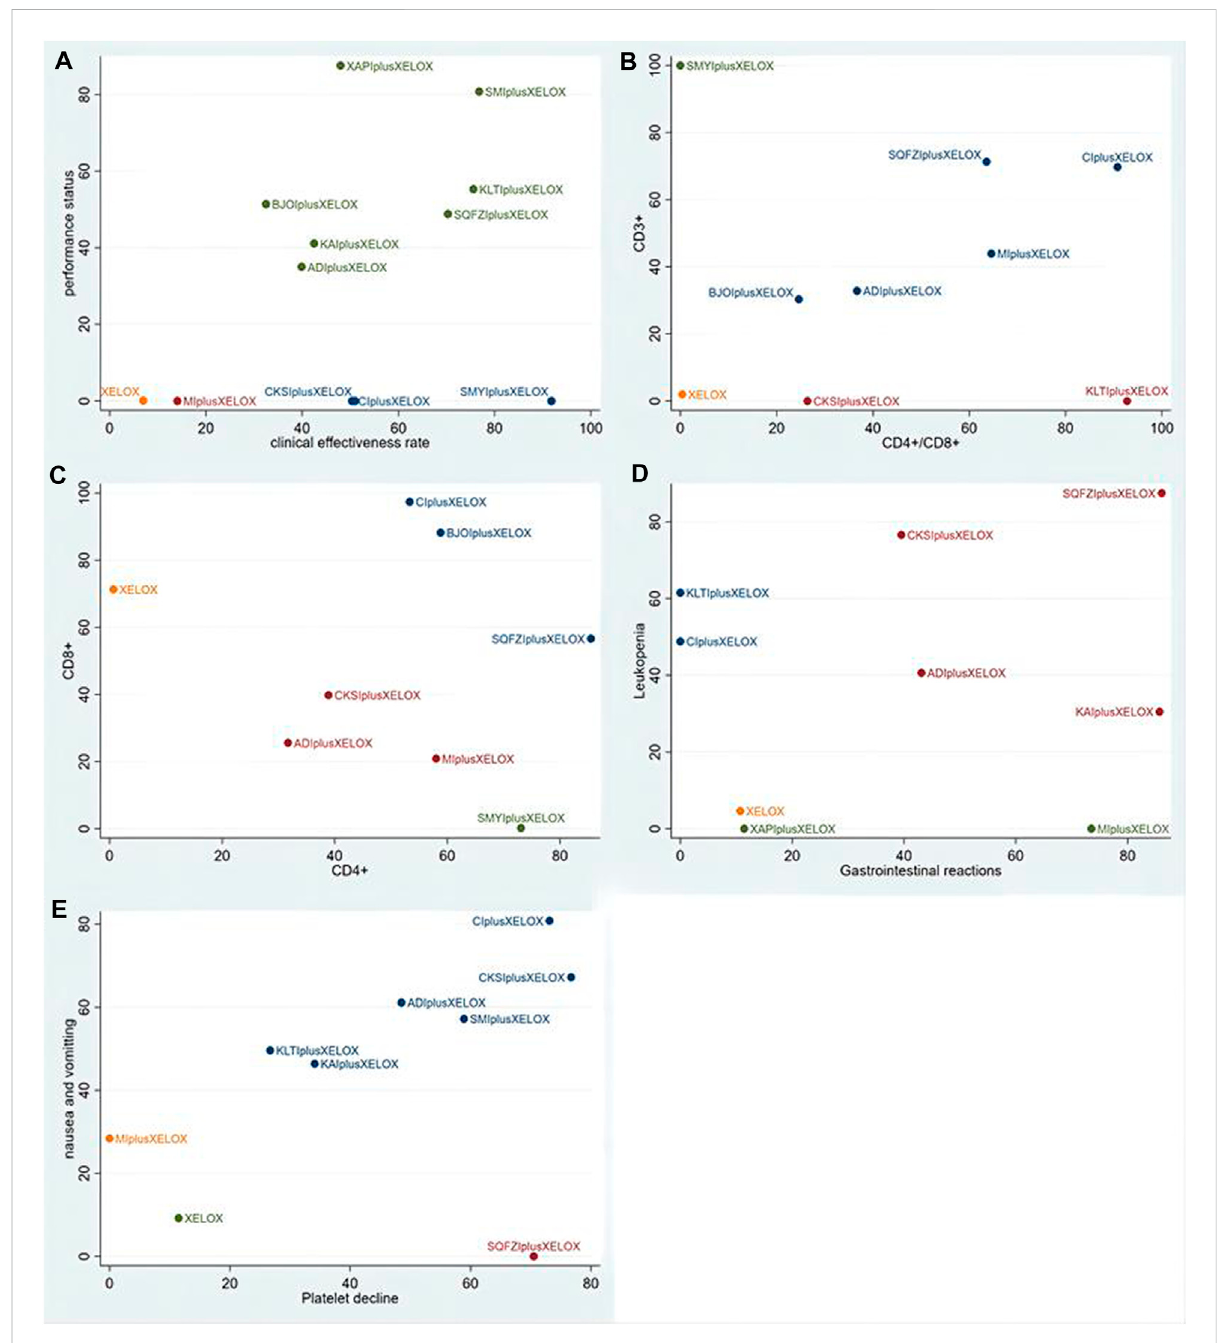
FIGURE 6 Cluster analysis plots: (A) the clinical effectiveness rate ( x -axis) and performance status ( y -axis); (B) CD4+/CD8+ ( x -axis) and CD3 + ( y -axis); (C) CD4 + ( x -axis) and CD8+( y -axis); (D) Gastrointestinal reactions ( x -axis) and Leukopenia ( y -axis); (E) Platelet decline ( x -axis) and nausea and vomitting ( y